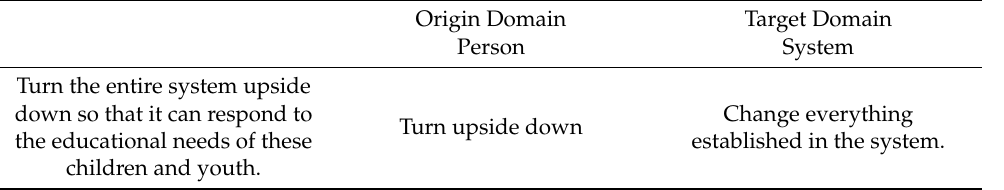
Table 12. The System is a